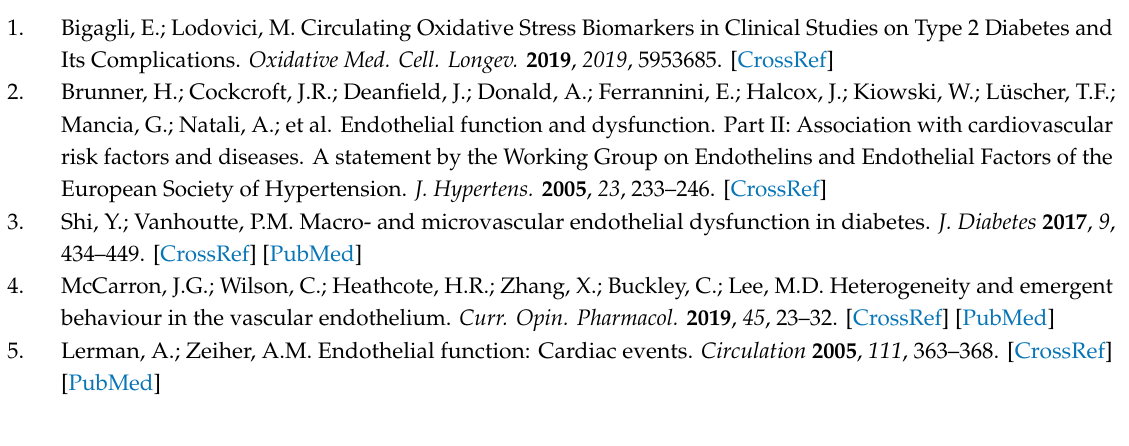
Table S1: Vasoactive agents used in vascular reactivity